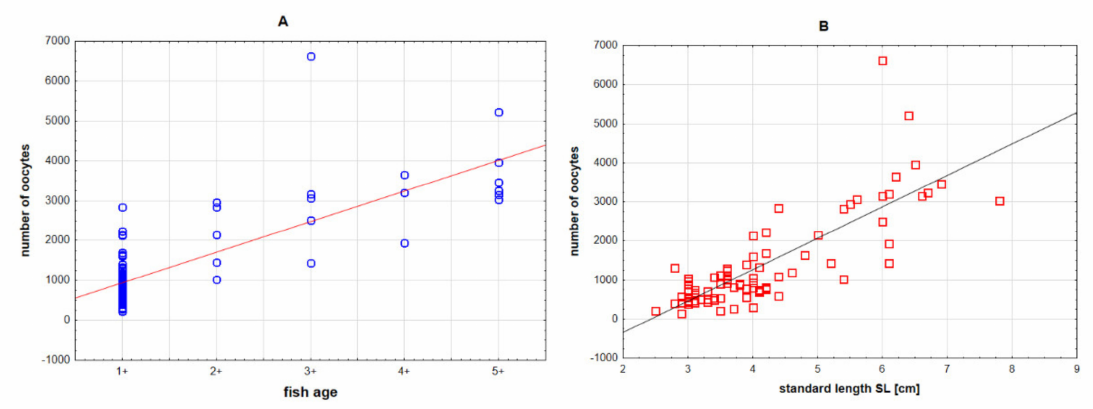
Figure 7. Relationship between number of oocytes and age ( A ) and standard length ( B ) in stone moroko Pseudorasbora parva inhabiting the Wardynka river,